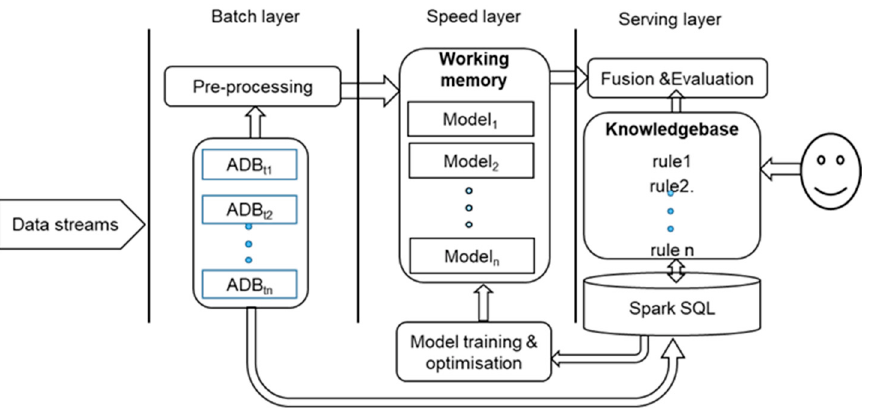
Figure 4. The system implementation under the lambda architecture.